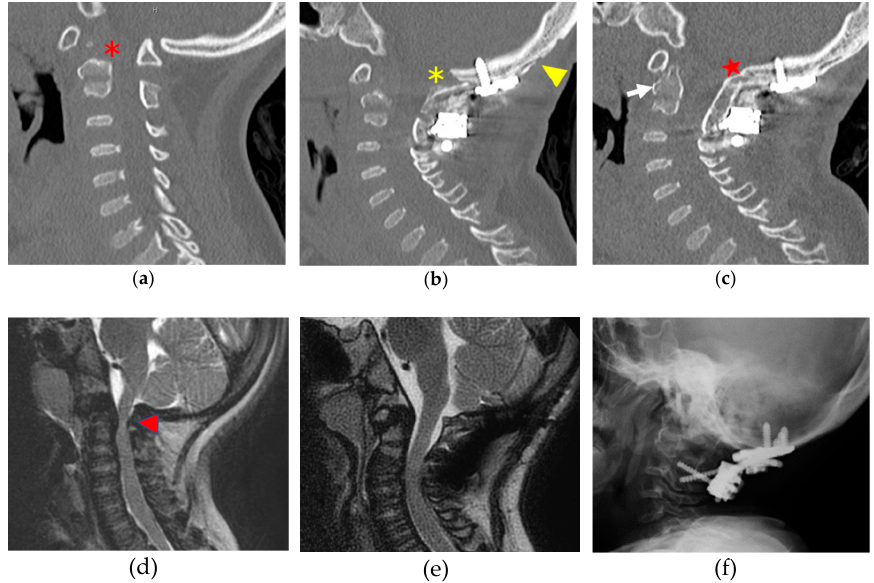
Figure 3. Occipito–cervical fusion in MPS IVa (10-year-old girl). Hypoplasia of the dens and the C1 posterior arch (asterisk) in the computed tomographic image causing spinal cord compression and myelomalacia (arrowhead) in the magnetic resonance image before surgery ( a , d ). Occipito–C2 fusion surgery was performed, and the spinal canal was totally decompressed at the occipito–cervical junction. The outer plate of the occipital bone (yellow arrowhead) was used for bone grafting material (yellow asterisk) ( b , e ). Good bone union (red star) was achieved and, interestingly, bone formation in the dens (white arrow) was observed 10 months postoperatively. C2 laminar screws combined with occipital plating were used for this surgery ( c , f ).